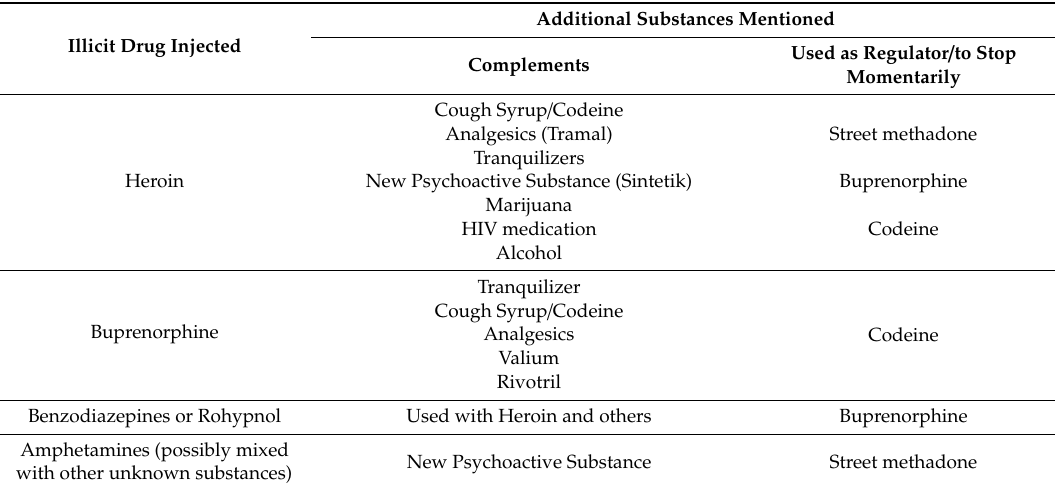
Table 3. Polydrug use among heroin